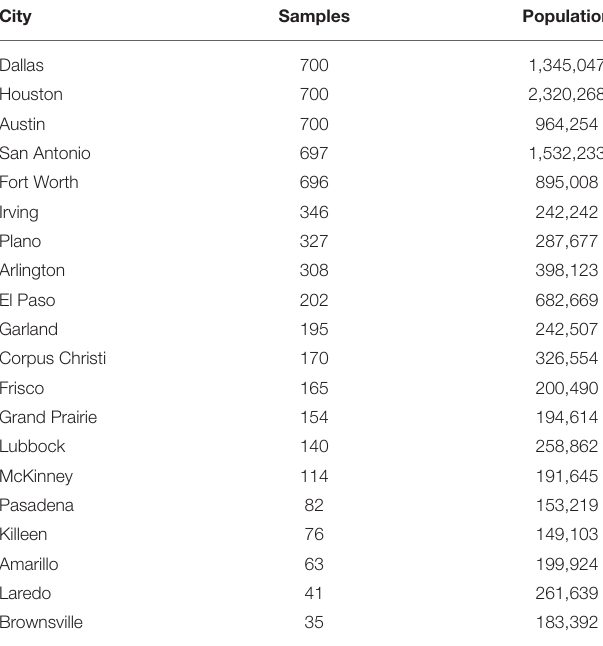
TABLE 2 | Lists the key attributes for each housing unit as well as associated census tract attributes which were used as covariates during